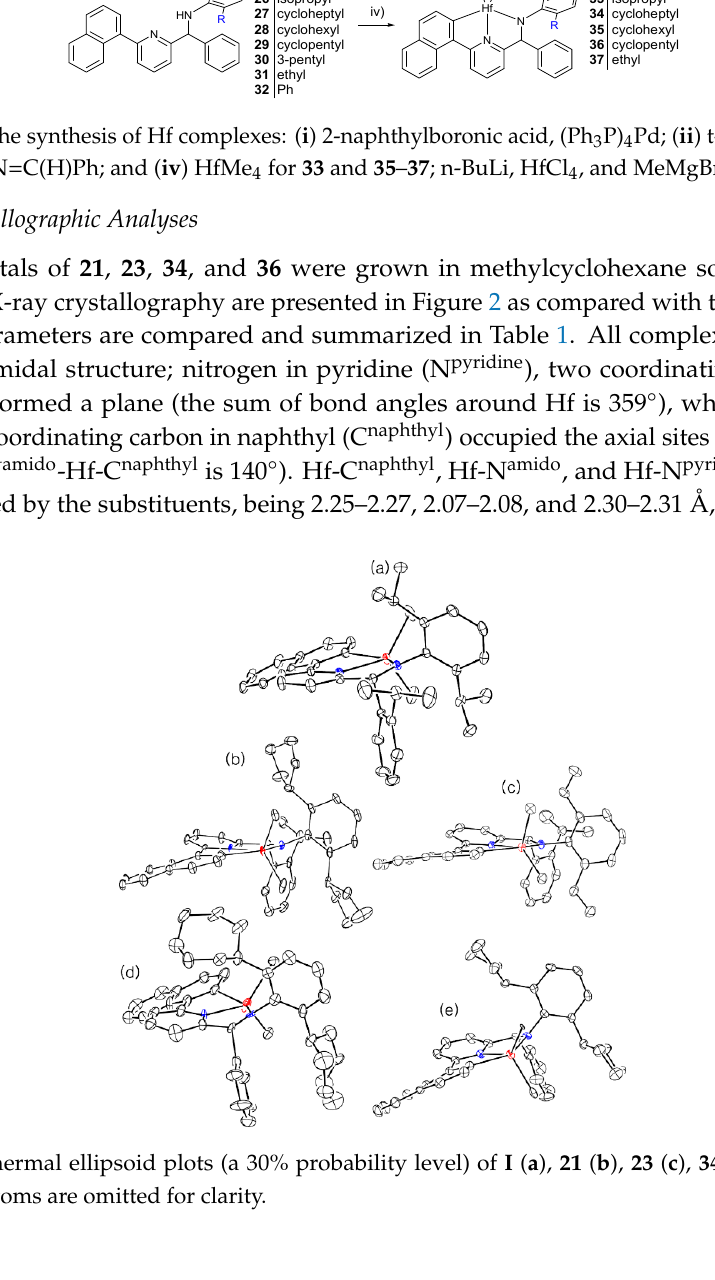
Table 1. Bond distances (Å) and angles (°) determined by X-ray crystallography.